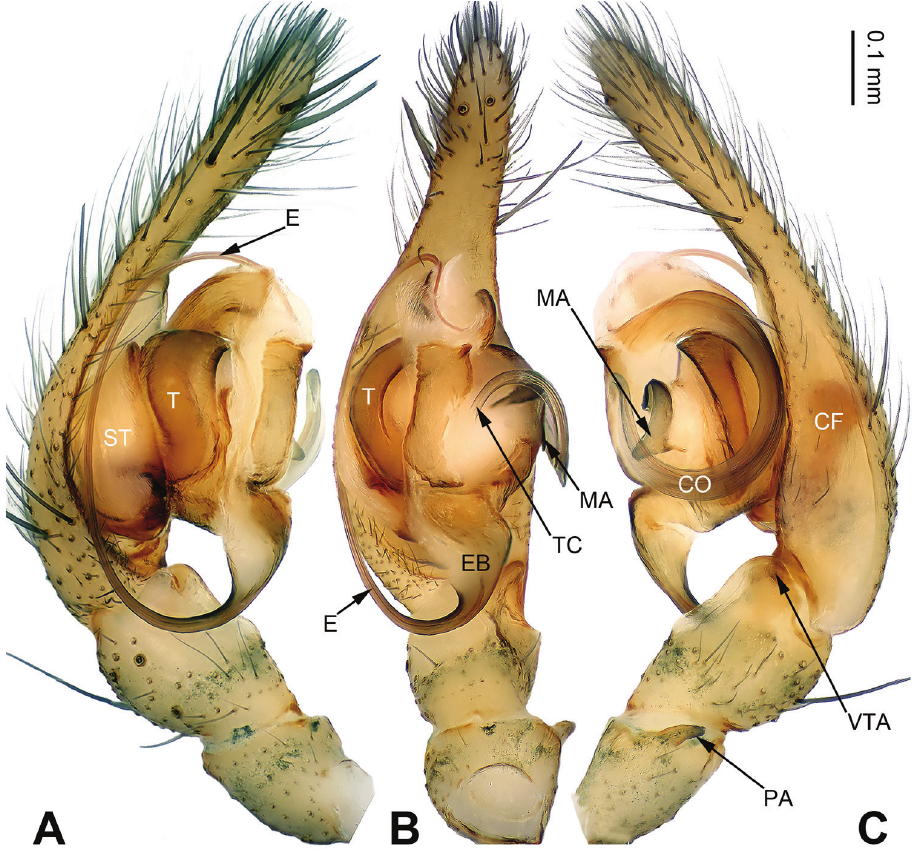
Figure 1. Palp of Pireneitega huashanensis sp. n., male holotype. A Prolateral view B Ventral view C Ret- rolateral view. Scale bar: equal for A, B, C